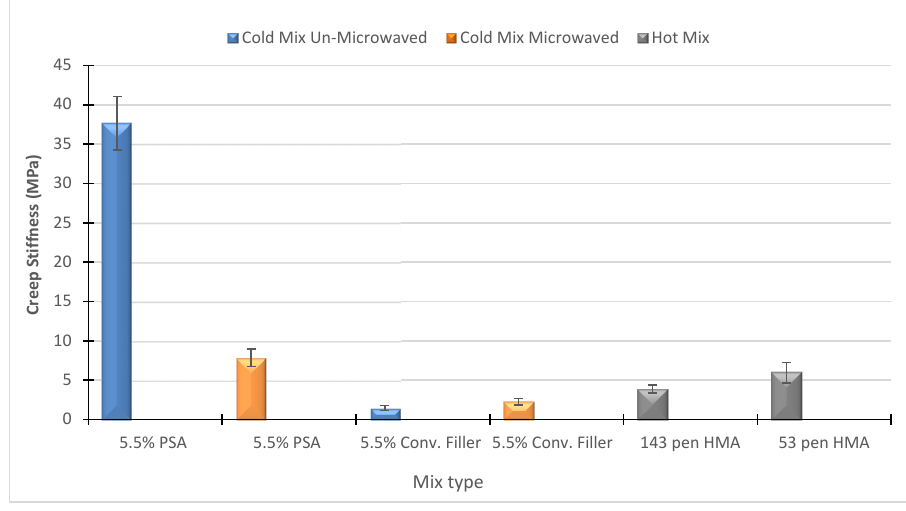
Figure 10. Effect of MW treatment on creep rate. 3.4. Effect of MW Treatment on CBEM Durability The indirect tensile stiffness ratio (SMR) test’s results are presented for the CBEMs to check the mixture’s adequacy to water sensitivity. SMR is the ratio of ITSM of the conditioned sample over ITSM of the un-conditioned sample. Unconditioned specimens were cured at 20 °C for 10 days and specimens were cured at 20 ° C for seven days; they were put in a vacuum for one hour prior to being submerged in a water bath at 40 °C for three days.